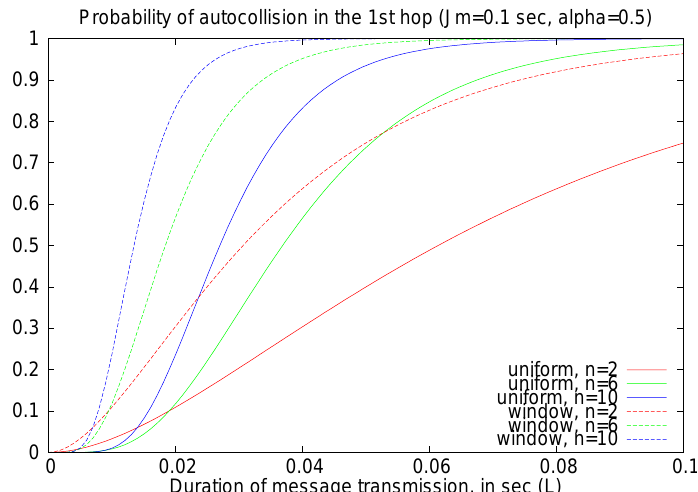
Figure 8. Probability of auto-collision in the first